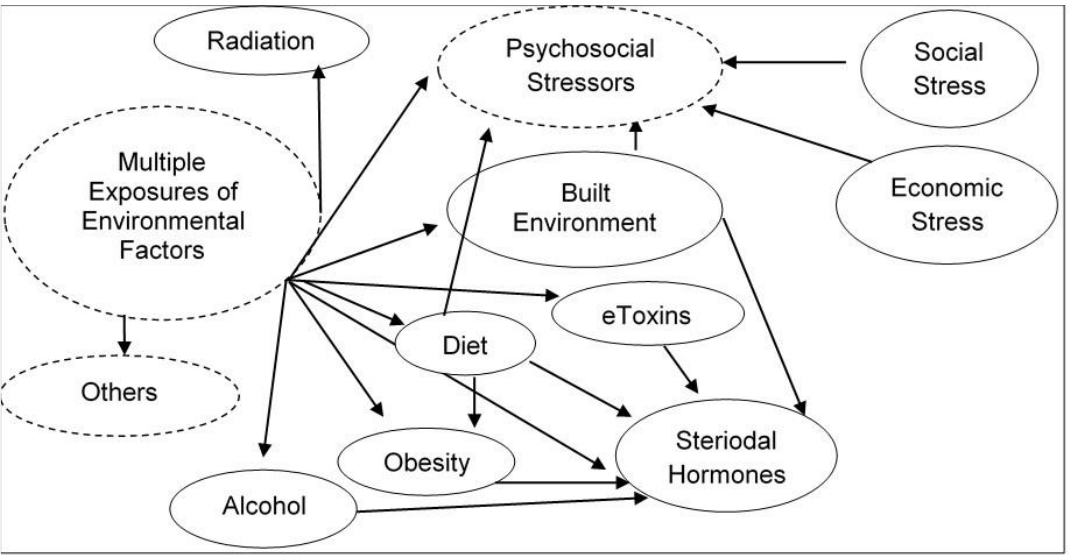
Figure 1. Illustration of complexity of cumulative multiple exposures of environmental stressors and their interactions in real-life human environmental